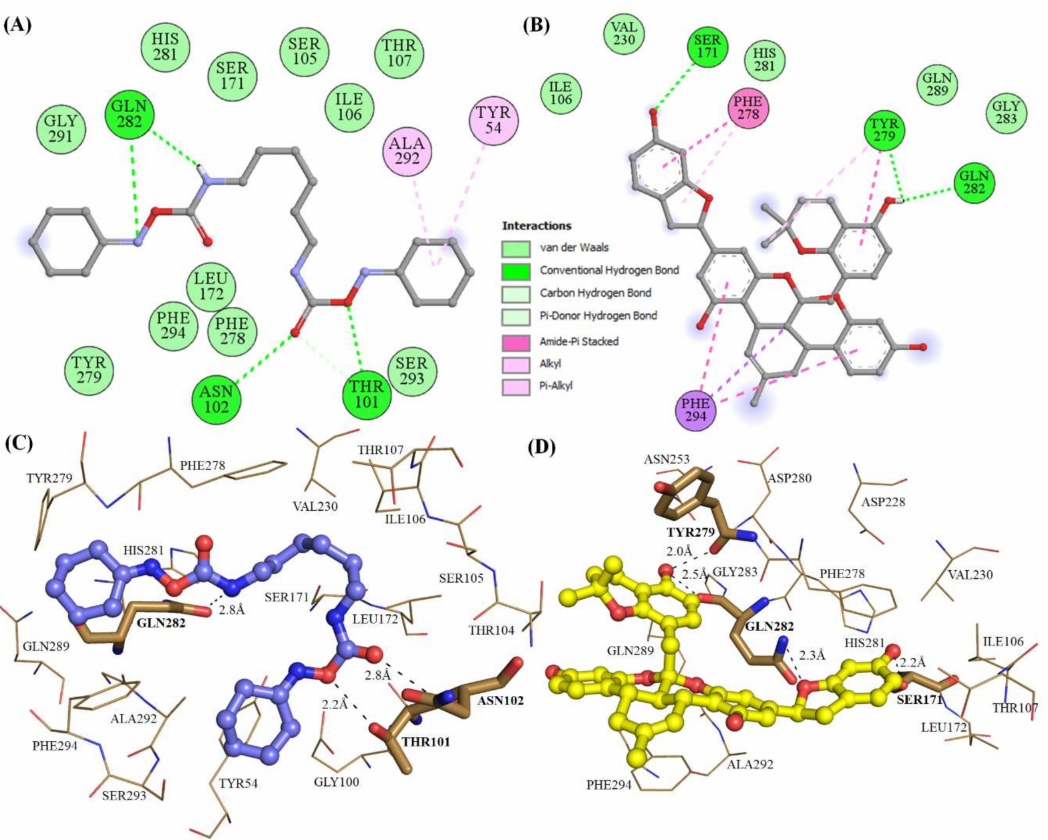
Figure 2. Catalytic pocket’s residue interactions of Mrlip1 with compounds. ( A – B ) 2D diagram of Mrlip1 residues interacting with compound RHC80267 and ZINC85530919 respectively. ( C – D ) 3D view of binding pocket residues of Mrlip1 interacting with compound RHC80267 and ZINC85530919 respectively. (Bold-labeled residues in stick model: forming polar contacts with the ligands and residues showing in lines participating in other